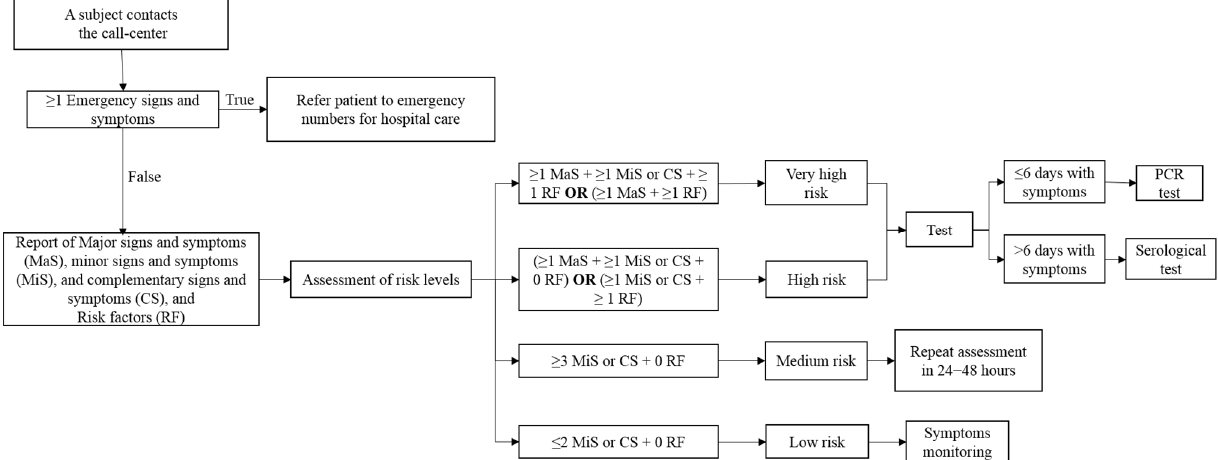
Figure 1. Algorithm to determine if a subject is a candidate for the test. Emergency signs and symptoms: difficulty breathing, bluish lips, chest pain, difficulty standing up, convulsions; major signs and symptoms (MaS): fever, dry cough, headache, irritability (children), loss of smell (anosmia), loss of taste (dysgeusia); minor signs and symptoms (MiS): shivers, muscular pain/soreness, bone pain, runny nose (rhinorrhea), sore throat, conjunctivitis; complementary signs and symptoms (CS): flu or cold, generally feeling unwell (malaise), tiredness/fatigue, cough with expectoration (phlegm), diarrhea, vomit, abdominal pain, fast breathing, nasal congestion; risk factors (RF): contact with suspected/confirmed COVID-19 case, healthcare worker, >60 years old, pregnancy, diabetes mellitus, hypertension, chronic obstructive pulmonary disease (COPD), asthma, immunosuppression, human immunodeficiency virus/acquired immunodeficiency syndrome (HIV/AIDS), heart disease, obesity, kidney failure, smoking, cancer, liver failure, the time frame between symptoms appearance and seeking medical care is >5 days.